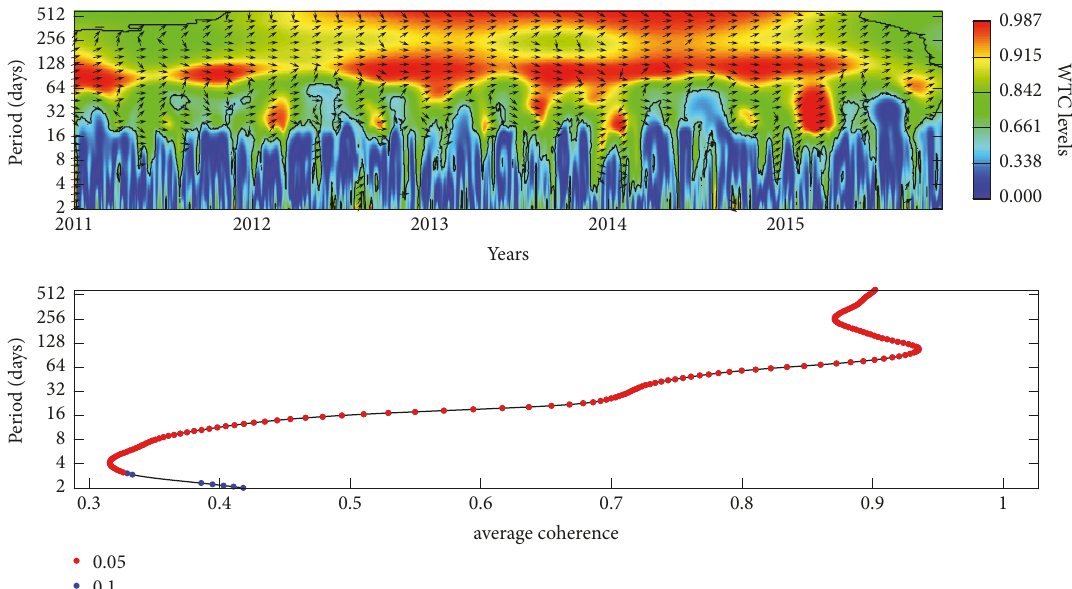
Figure 2: WTC, phase analysis, and average coherence between the air temperature and the daily electricity demand. The black lines show area with 95% of confidence while red and blue points depict the points of 5% and 10% significance level.